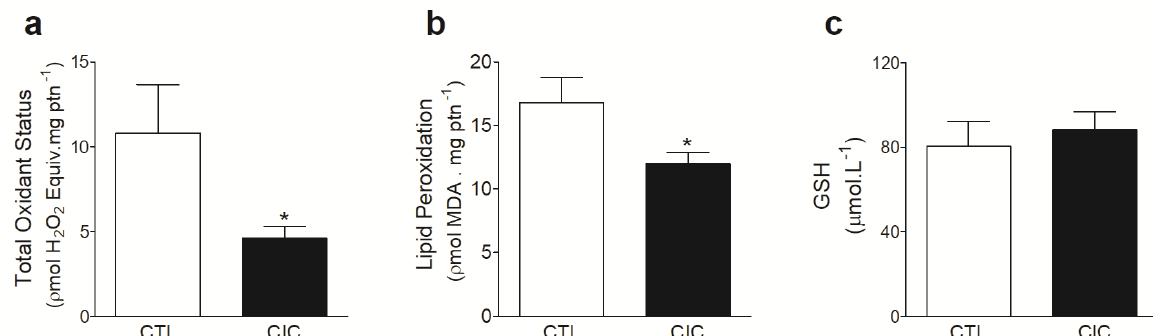
Figure 6. Evaluation of redox status. a. Total oxidant status (CTL, n = 10; CIC, n = 14), b. Lipid peroxidation (CTL, n = 10; CIC, n = 14) and c. GSH (CTL, n = 5; CIC, n = 9) for CTL and CIC groups. Data are mean ± S.E.M., analyzed by Unpaired Student t test. *P<0.05 compared to the CTL